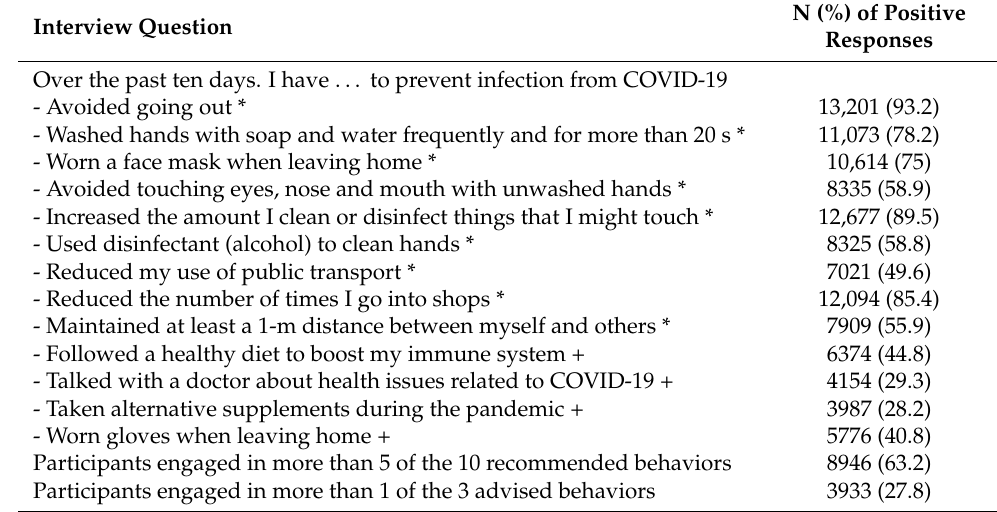
Table 1. Safety behavioral responses to the COVID-19